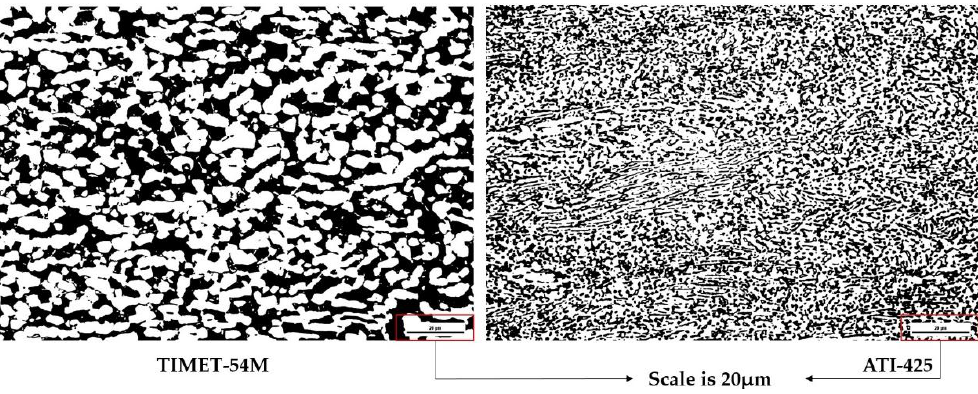
Figure 11. ImageJ analysis of TIMET-54M and ATI-425, for P1. TIMET-54M and ATI-425 have β percentages of 45.3099% and 41.5035%, respectively.